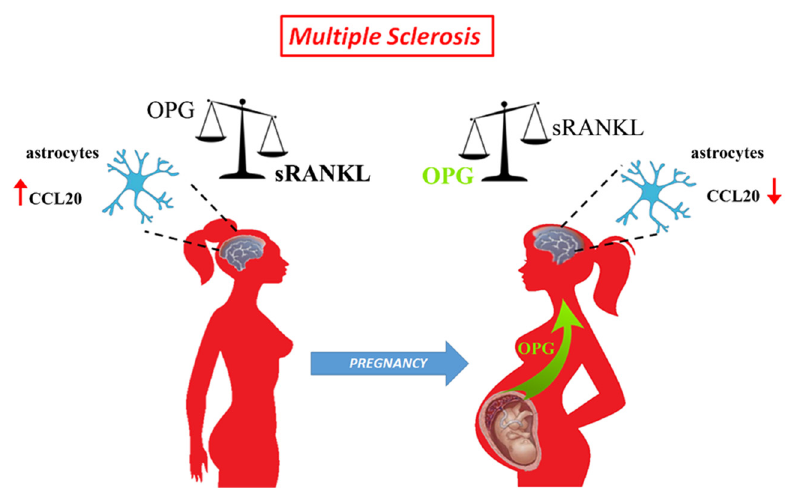
Figure 5. Schematic representation of the effect of pregnancy on sRANKL to OPG ratio in multiple sclerosis patients. MS patients have a dysregulated sRANKL to OPG ratio and increased expression of CCL20 within the CNS. During the third trimester of pregnancy, the placenta releases OPG in the maternal circulation. Placental OPG reverts the sRANKL/OPG balance, exerts inhibition on RANK-RANKL interaction within the maternal CNS, and leads to a reduction of CCL20 by astrocytes.